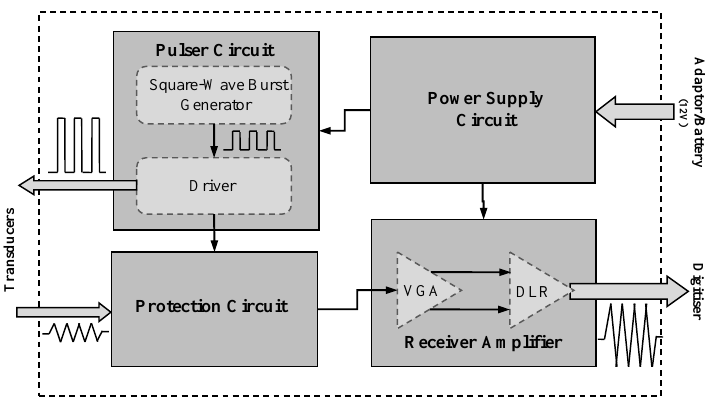
Figure 5. Schematic of the ultrasonic unipolar square wave front-end.